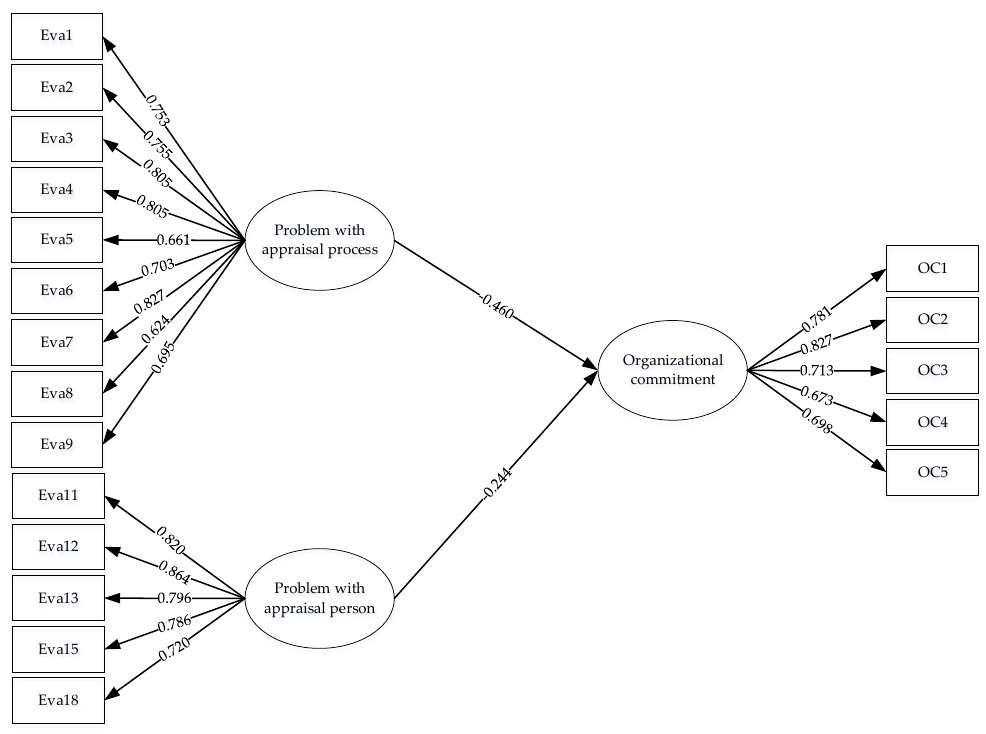
Scheme 3. Influence of appraisal problems on organizational commitment (OC).